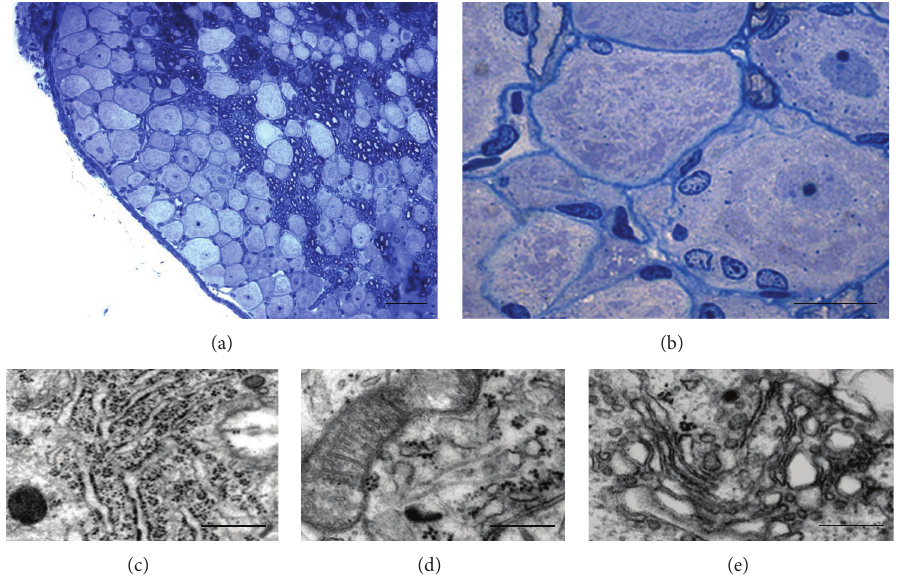
Figure 5: Resin-embedded 2.5 𝜇 m semithin sections of crushed DRG at low (a) and high (b) magnification stained with toluidine blue. The ultrastructural analysis in electron microscopy shows that sensory neurons are particularly rich in organelles as RER (c), mitochondria (d), and Golgi apparatus (e). Scale bars: a = 50 𝜇 m; b = 20 𝜇 m; c–e = 0.5 𝜇